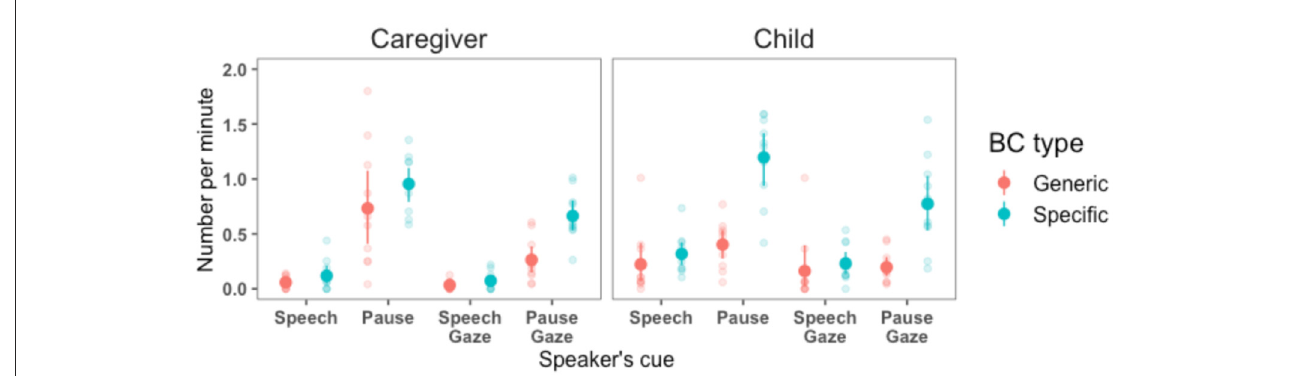
FIGURE4 The rate of listener’s BC production of children and caregivers across the speaker’s speech and pauses (mutually exclusive). We also show the subset of cases where these cues overlap with the speaker’s gaze at the listener. Each data point represents a participant and ranges represent 95% confidence intervals.